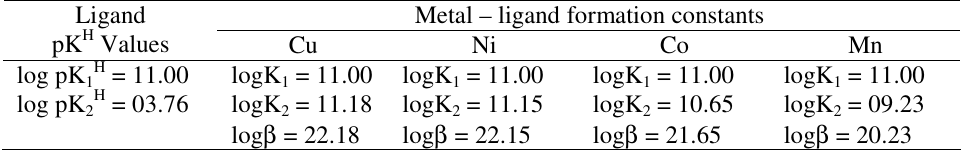
Table 1. Proton ligand and binary metal ligand stability constants of metal complexes at temperature 30 ± 0.2 °